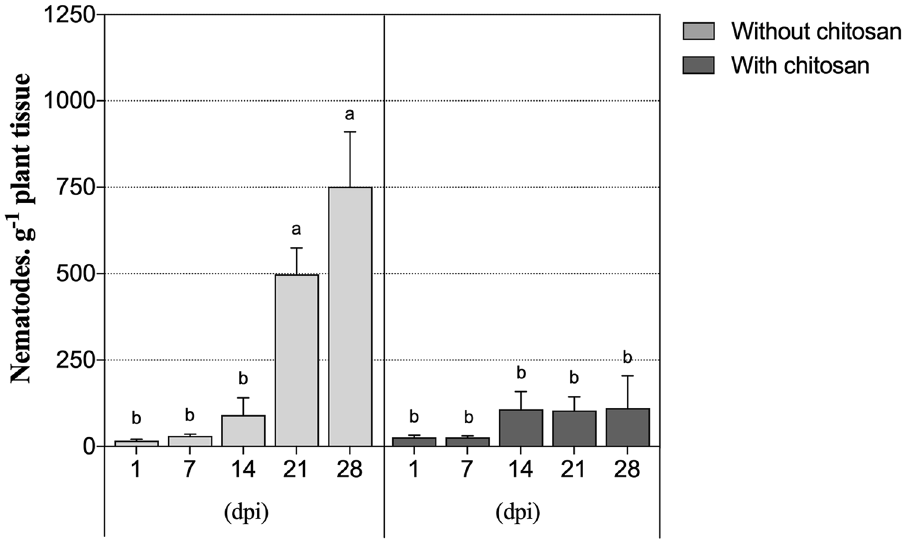
Figure 1. Nematode population in plant tissues. Nematode density in P. pinaster stem tissues 1, 7, 14, 21 and 28 days post-inoculation (dpi). Plants were inoculated with the pinewood nematode (PWN) B. xylophilus 14 days following the application of 0.5% acetic acid (without chitosan, non-elicited controls) or a chitosan solution to plants’ substrate. Data represents the difference between the averages of PWN-inoculated and water- inoculated plants ± SE, and different letters indicate statistically different means at P < 0.05.